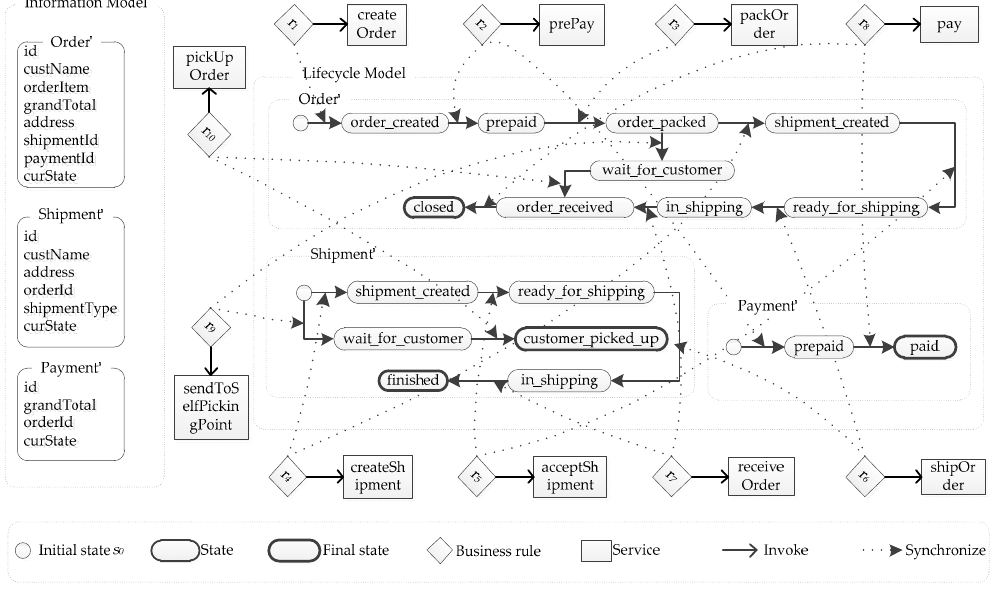
Figure 5. The purchase business process model M P' .